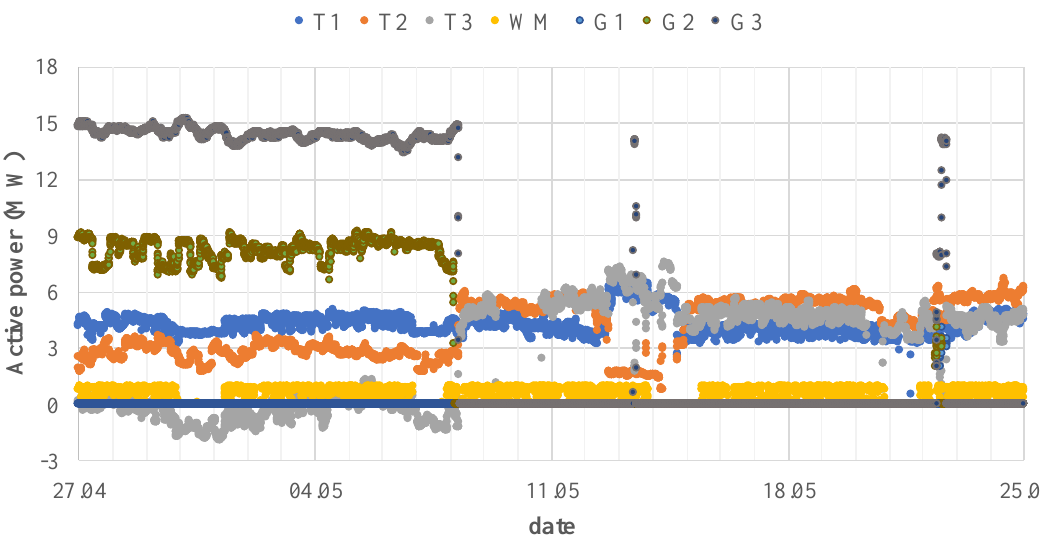
Figure 3. Active power of the high/medium (HV/MV) transformers T1, T2, and T3, welding machine (WM), and distributed generations G1, G2, G3 using the MV side measurements.